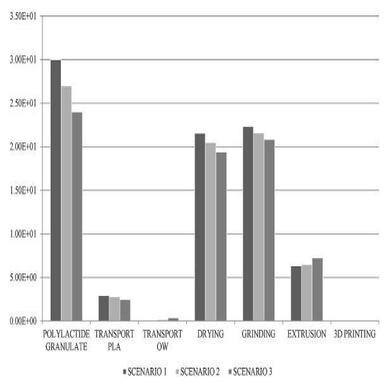
Process contribution to GWP impact (kg CO2 eq.) for each FFF printing process stage.